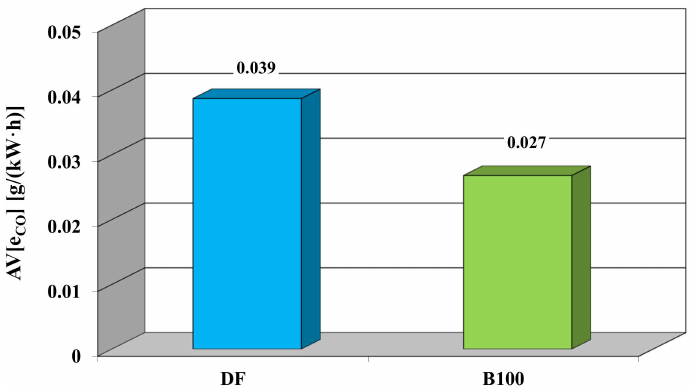
Figure 9. Average value—AV in the speed domain of the specific brake emissions of carbon monoxide—e CO for the engine powered with fuels DF diesel or B100.